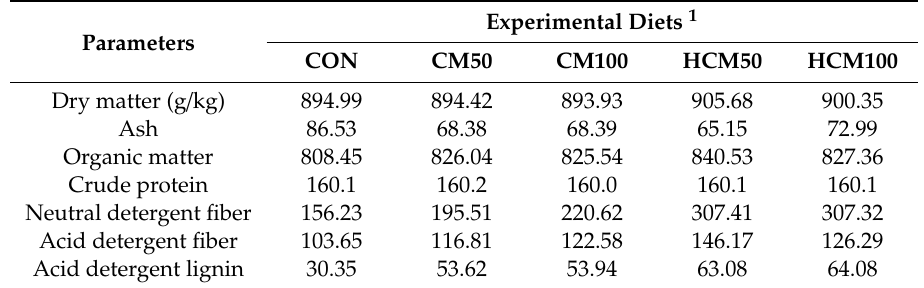
1 Experimental diets: CON, commercial lamb finishing diet in which SBM was the major protein source; CM50, commercial finishing diet in which 50% of SBM was replaced with untreated canola meal; CM100, commercial finishing diet in which all SBM was replaced with untreated canola meal; HCM50, commercial finishing diet in which 50% of SBM was replaced with heat-treated canola meal; and HCM100, commercial finishing diet in which all SBM was replaced with heat-treated canola